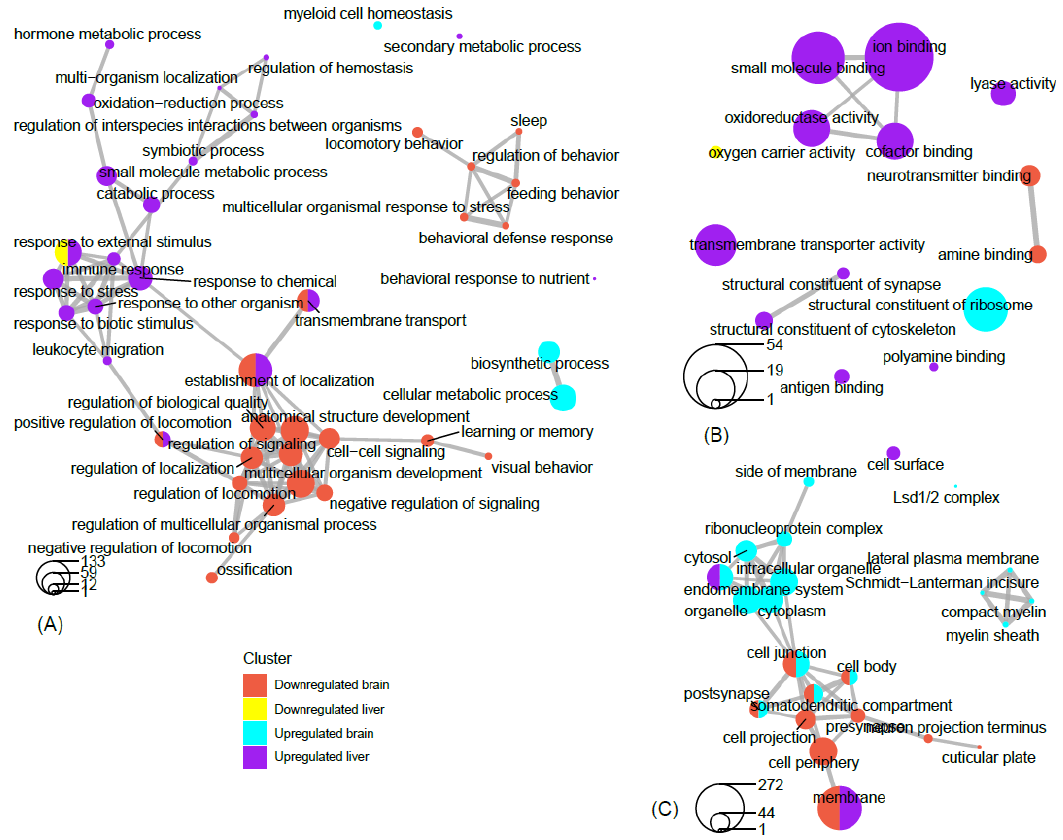
Figure 8. Network view of GO term association. Network plots of the top filtered GO terms, depicting the degree of connectivity within and between terms of enriched genes that are up-regulated in the brain, up-regulated in the liver, down-regulated in the brain, and down-regulated in the liver. The circles-legend at the bottom of each left-hand corner indicates the number of genes that are enriched for a given term. Connecting lines indicate a significant degree of semantic similarity between terms. Biological process ( A ), cellular component ( B ), and molecular function ( C ). GO terms were filtered (level = 3) to reduce redundancy and capture major categorical themes prior to visualization of connectivity in network plots, which were designed in R using the cluster Profiler package. Plots of filtered GO terms contained the top 20 significant categories, respectively, per subject cluster.